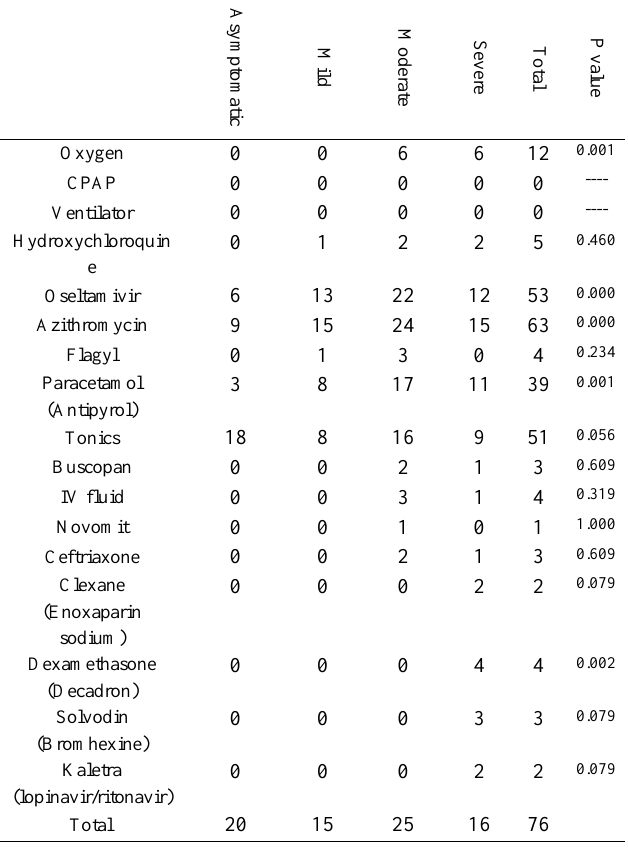
Table 4: Treatment and case